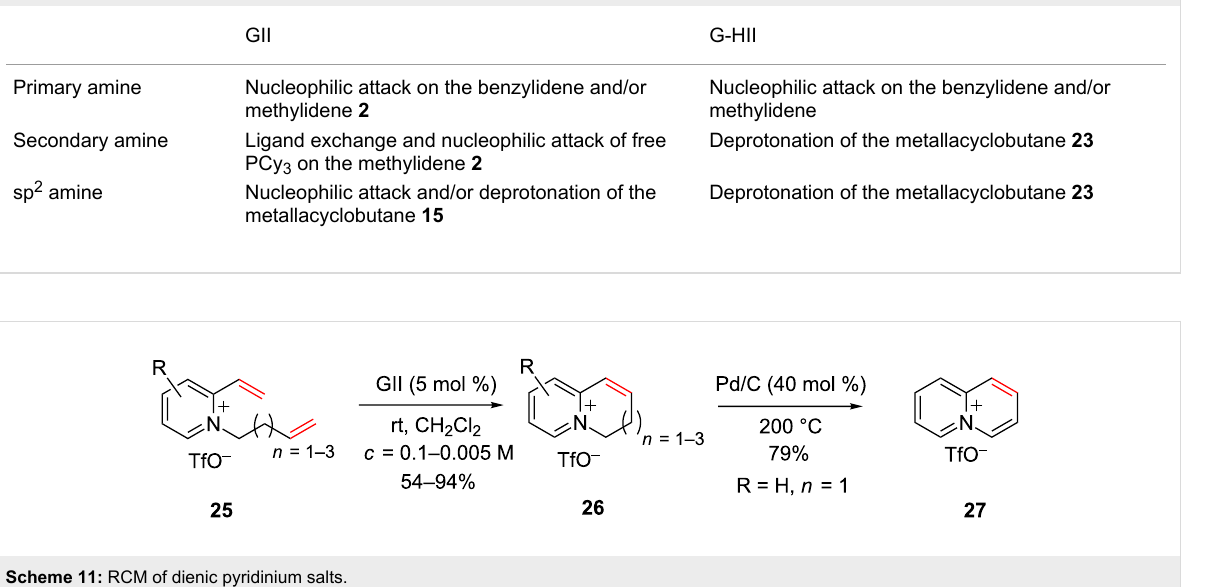
Scheme 11: RCM of dienic pyridinium